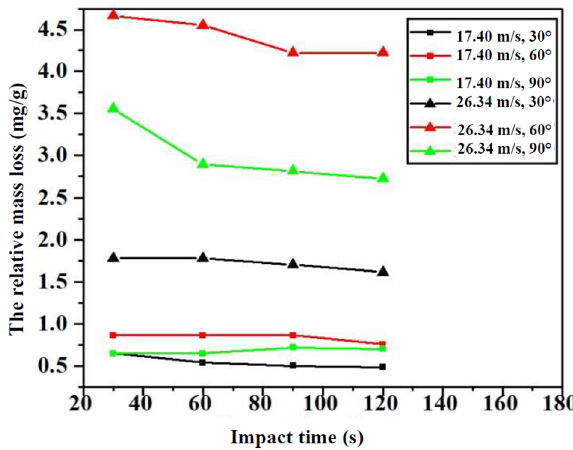
Figure 5. Relative mass loss of glass specimens with an increase in impact time.